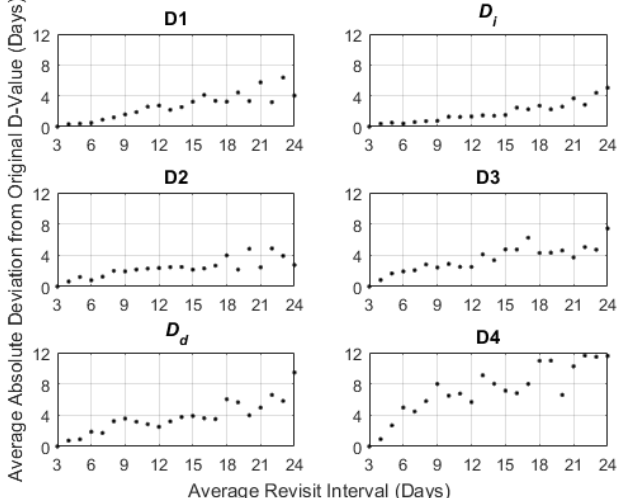
Figure 9. Average absolute deviations of D 1, D i , D 2, D 3, D d , and D 4 from the original D -values, shown as a function of average temporal revisit rate. Each data point represents the deviation of the calculated D -value across all resampled time-series at that particular image frequency. These statistics were collected separately for each individual plot and were then averaged for analysis; the data points presented above represent the average of statistics across all 32